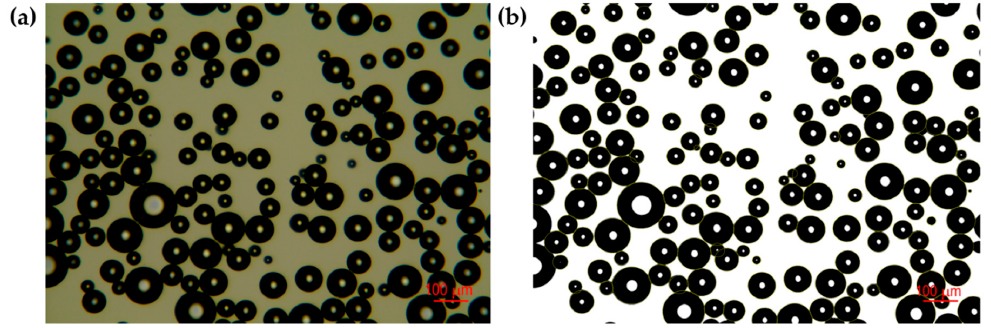
Figure 4. ( a ) A typical micrograph and ( b ) its detected edge by the image analysis software.